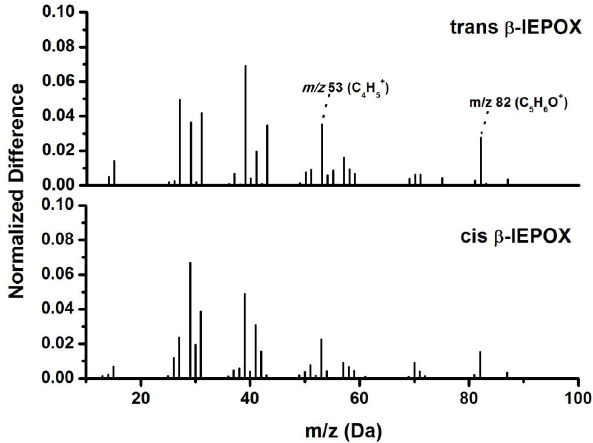
Fig. 5. ToF-AMS normalized difference spectra (composition at peak OA growth minus composition during seed injection), show- ing the organic composition of the OA produced by reactive uptake of the trans and cis isomers. Select nominal mass ions previously suggested to be IEPOX-derived OA tracers are